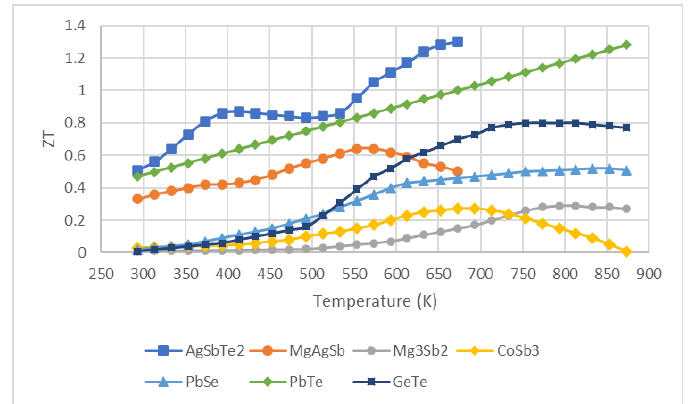
Figure 6. The thermoelectric performance of market standard thermoelectric materials over the mid-temperature range: AgSbTe 2 records the highest ZT value, and the peak efficiency of the PbTe is greatest of any of the materials across this range with a value of 19.22% at 873 K. MgAgSb has three different phase structures, α-MgAgSb, β-MgAgSb and γ-MgAgSb. Due to the twisted half-Heusler structure of α-MgAgSb, it has better thermoelectric properties, especially across the low- and mid-temperature ranges investigated here. The ZT value of GeTe increases at a much greater rate from 500 K and remains similar from 700 K onwards.